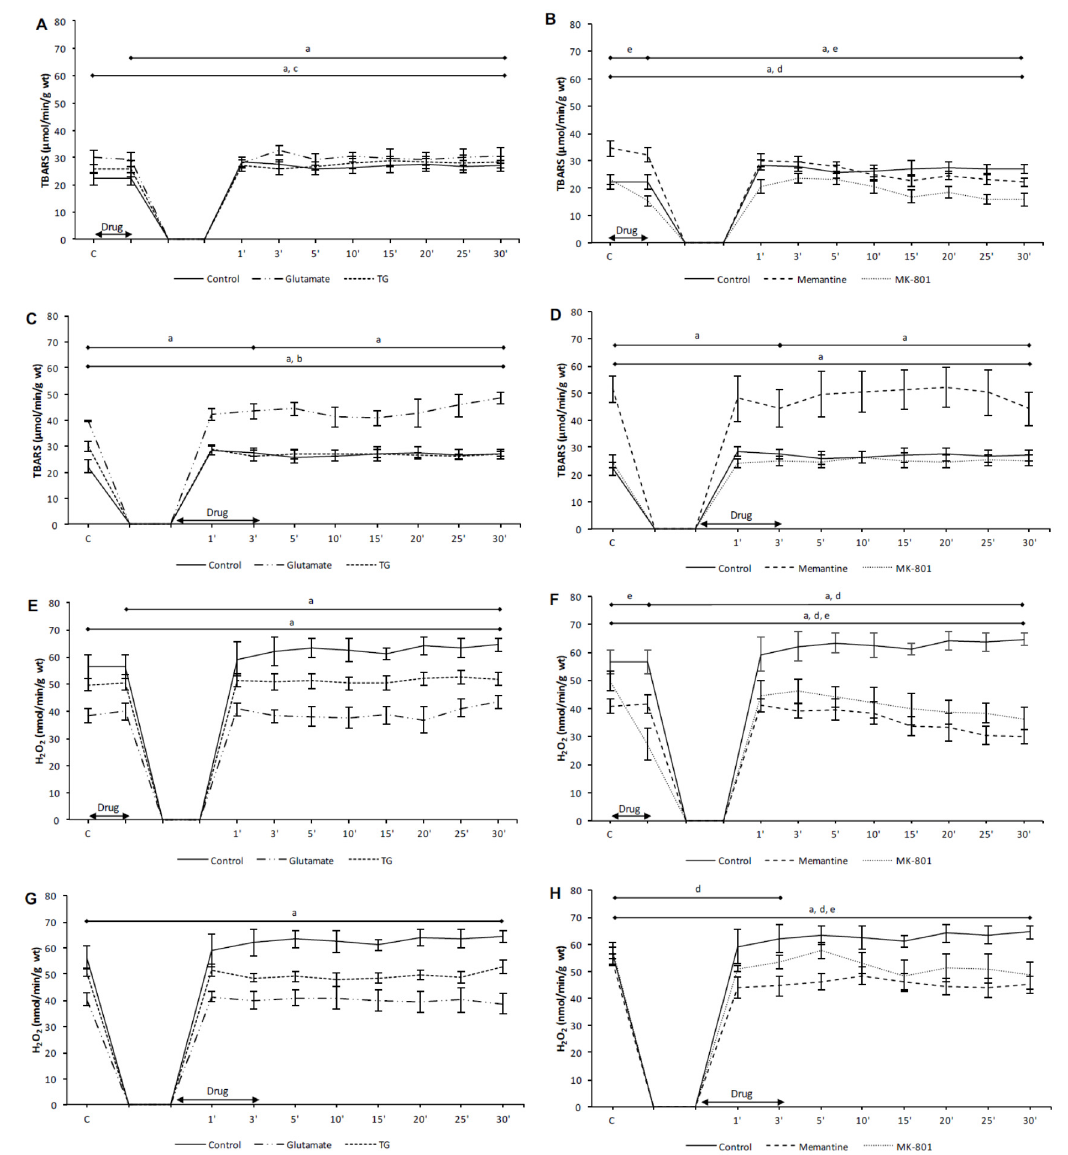
Figure 4. The effects of cardiac NMDAR modulation in preC and postC on TBARS and H 2 O 2 . ( A , E ) preconditioned with glutamate and TG; ( B , F ) preconditioned with memantine and MK-801; ( C , G ) postconditioned with glutamate and TG; ( D , H ) postconditioned with memantine and MK-801. TBARS—index of lipid peroxidation measured as TBARS; H 2 O 2 —hydrogen peroxide; TG—(RS)-(Tetrazol-5-yl)glycine; preC—preconditioning; postC—postconditioning. Some results glutamate group; c—in TG group; d—in memantine group; e—in MK-801 group. Statistical significance was considered significant if the p value was less than 0.05 ( p <